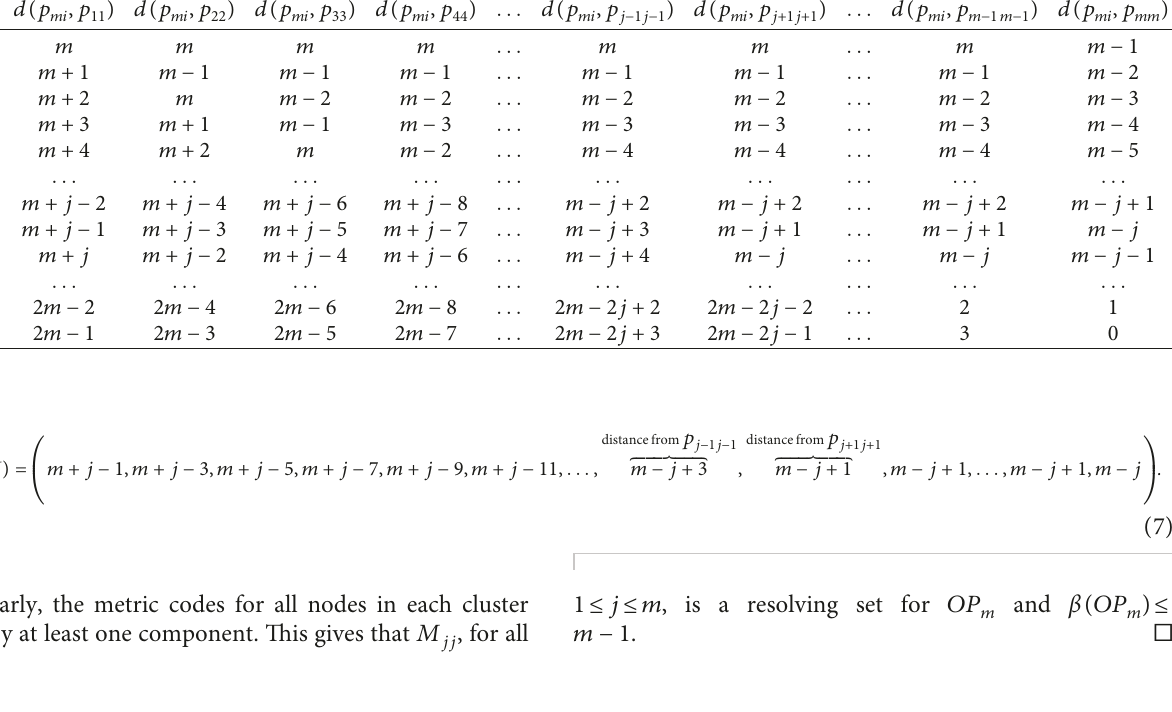
Table 4: Metric codes c